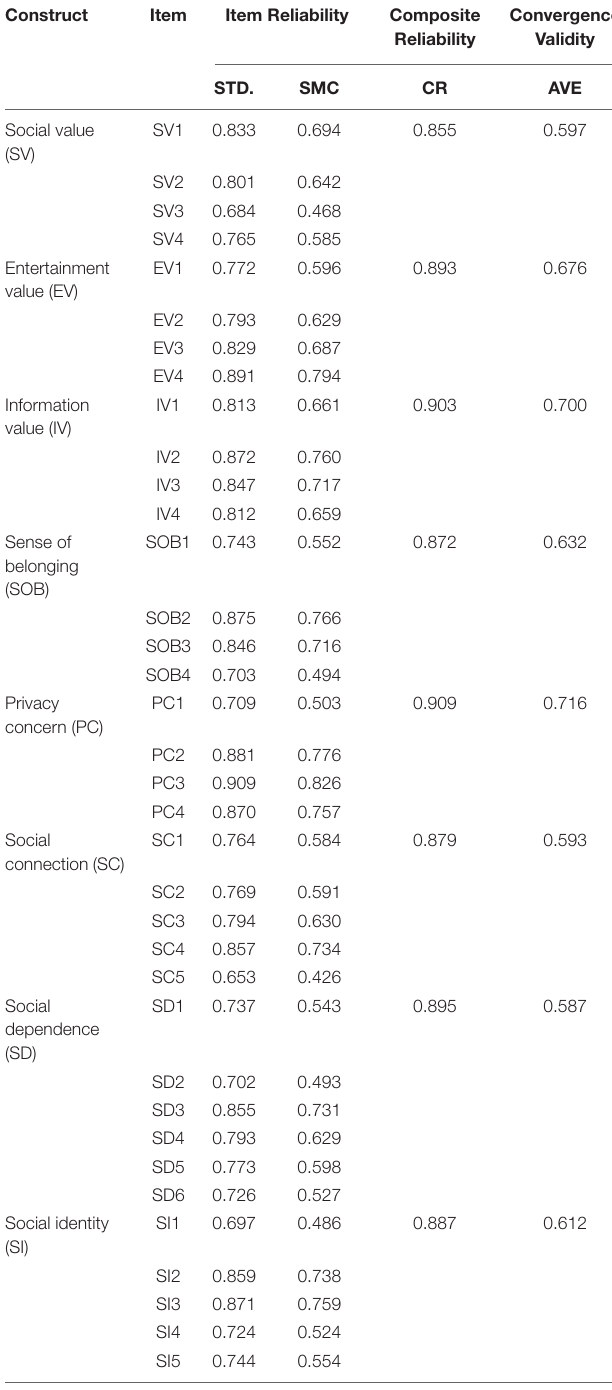
Table 7 reports the Discriminant validity for the measurement model, the square roots of the AVE are reproduced on the diagonal. Discriminant validity is the extent to which the